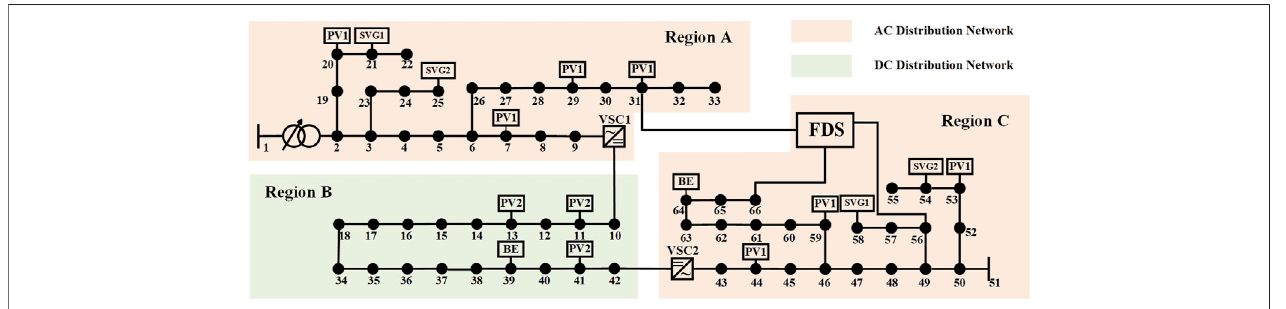
FIGURE 3 | Topology of the modi fi ed dual IEEE 33-node